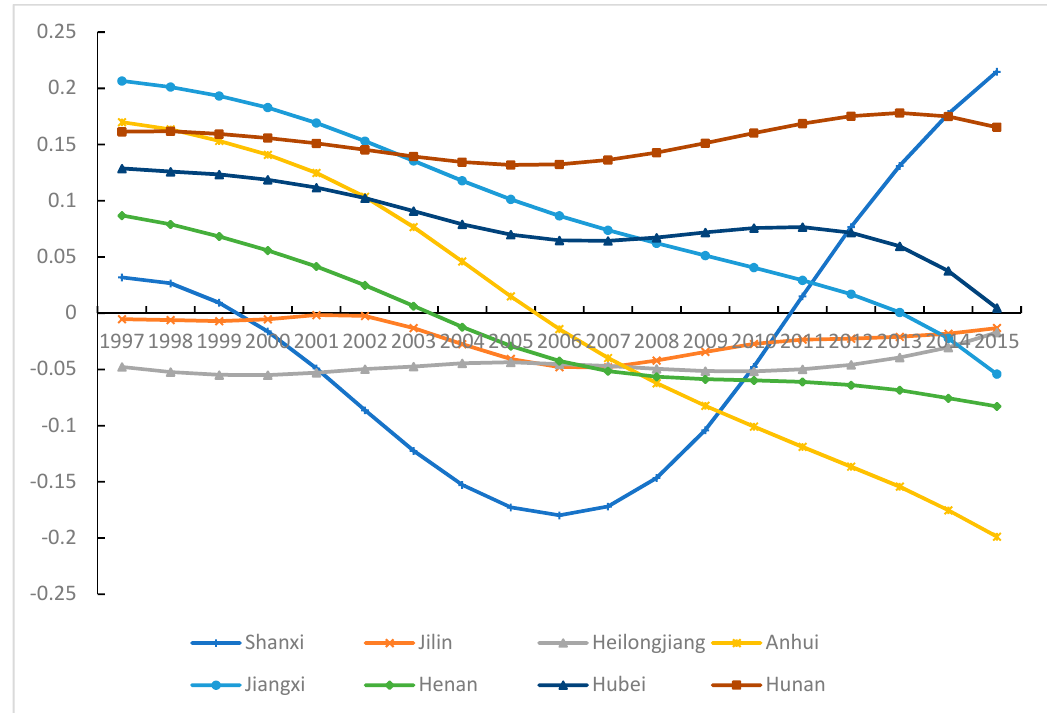
Figure 10. Parameter estimates of industrial pollution emissions in Central China.